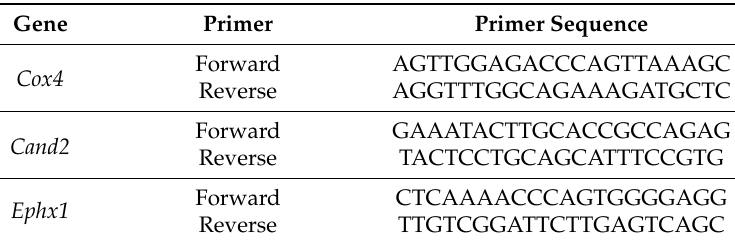
Table 2. qPCR primer sequences for D. pulex genes of